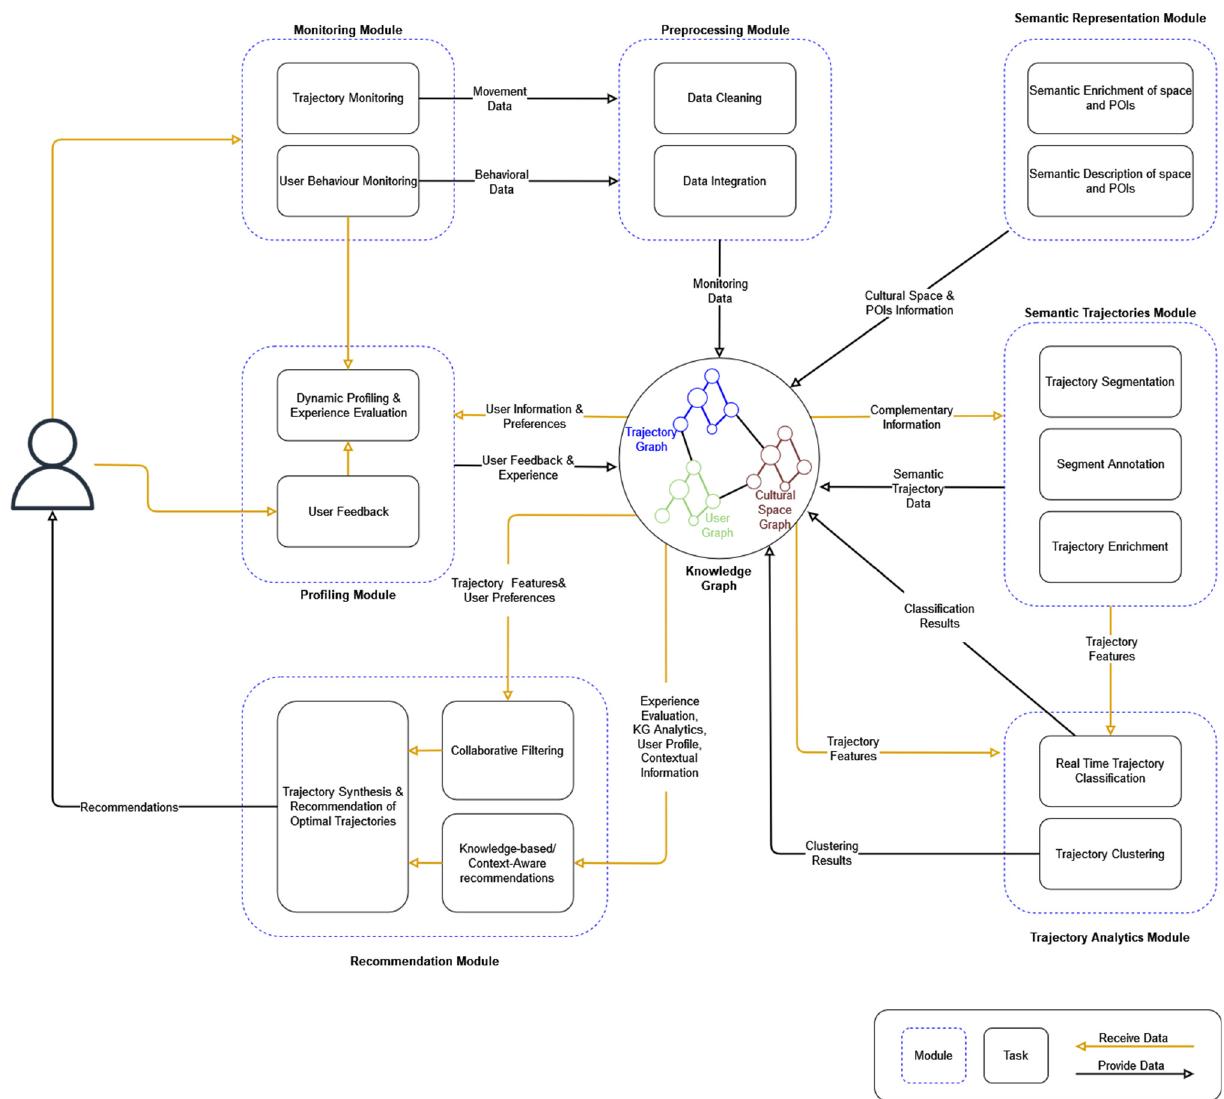
Figure 4. A system architecture design on the collaboration and information exchange between the Knowledge Graph and trajectory-oriented and recommendation-oriented components to provide optimal trajectory recommendations to the user.